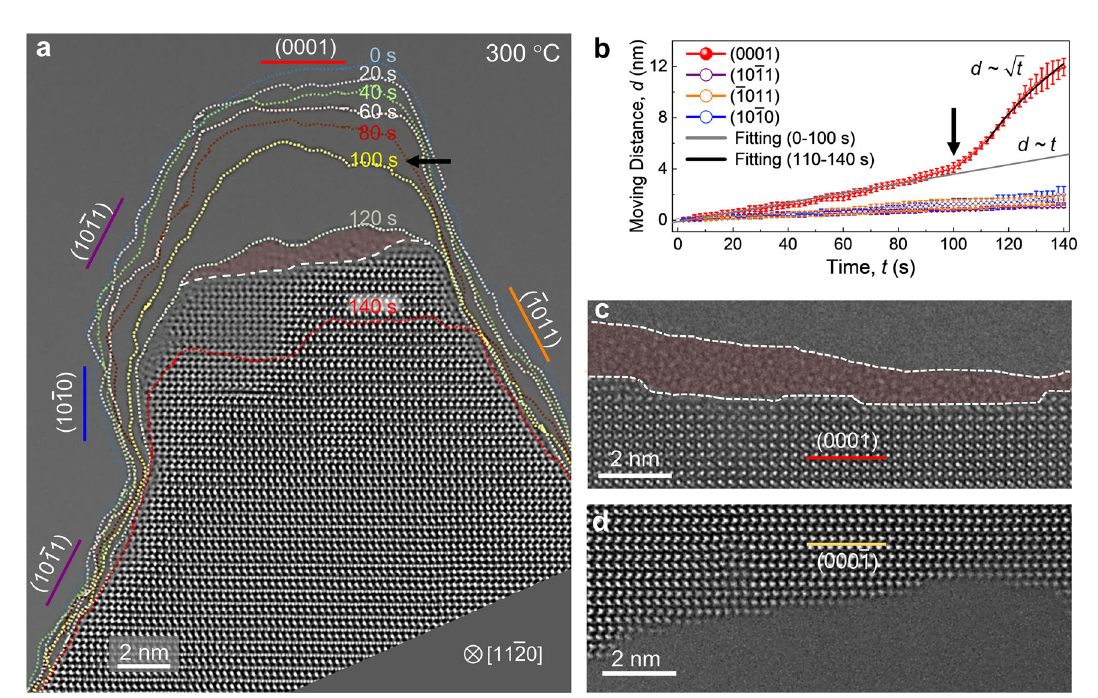
Fig. 2 | Anisotropic evaporation of ZnO observed by in-situ HRTEM. a Outlines of the polar (0001), semi-polar ð 10 (cid:1) 11 Þ , ð (cid:1) 1011 Þ and non-polar ð 10 (cid:1) 10 Þ surface edges overlaid on HRTEM image tracing their movements during evaporation at 300°C. The outlines of the edges traced in every 20s for total 140s are displayed in different colors. The quasi-liquid layer (highlighted in red) starts forming at ~100s only on the (0001) surface. Referring to Supplementary Movie 2 for the corre- sponding real-time process. b Plot of the moving distance, d of four major surface orientations during evaporationasafunction of time, t .The blackarrow marksthe timewhenaquasi-liquidlayerstartsformingonthe(0001)surfaceandthemoving